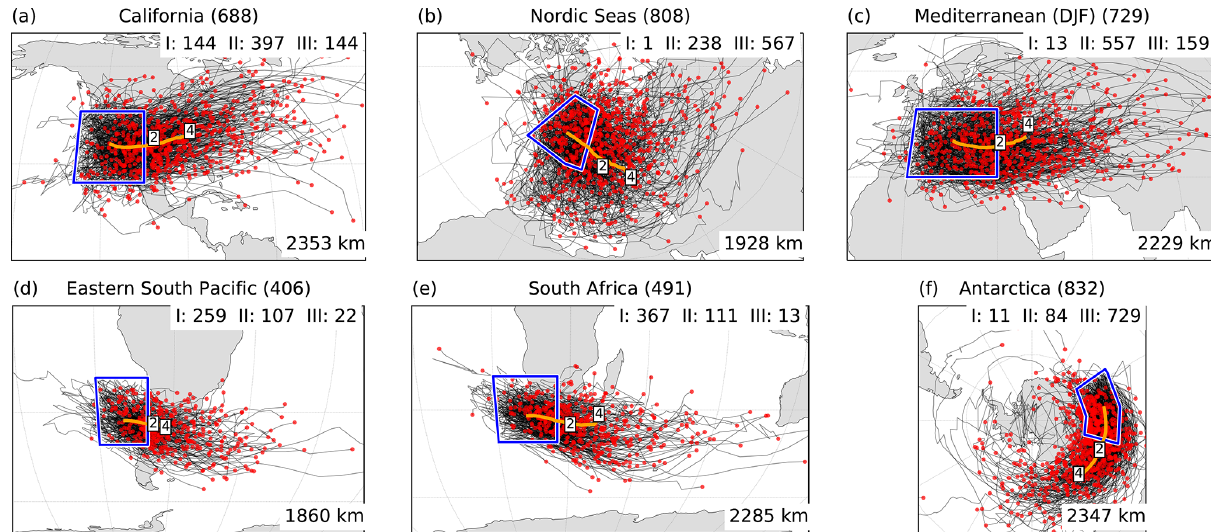
Figure 10. All tracks (black lines), lysis points (red dots), and average tracks (orange lines, including average location at days 2 and 4) of PV cutoffs with genesis over the six selected regions (blue boxes) in DJF: (a) California, (b) Nordic Seas, (c) Mediterranean, (d) eastern South Pacific, (e) South Africa, and (f) Antarctica. The average spherical distance between genesis and lysis is indicated at the bottom right of each